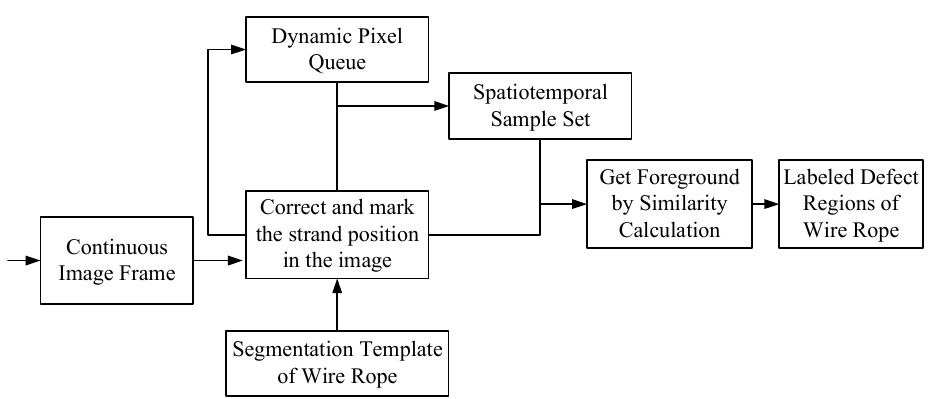
Figure 4. The main technical route of the proposed method.